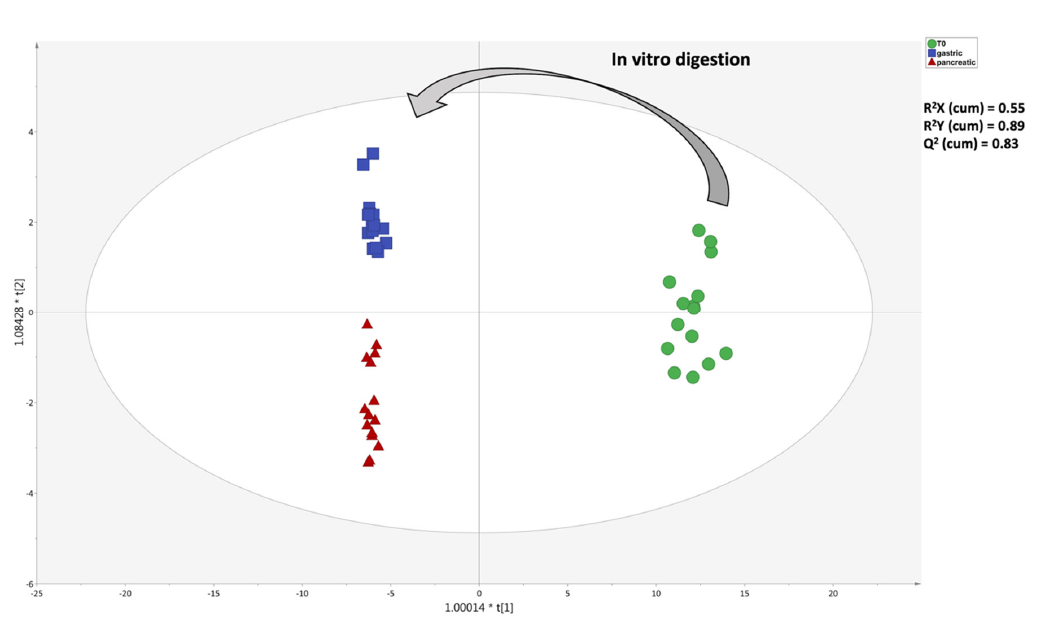
Figure 2. Orthogonal projection to latent structures discriminant analysis (OPLS-DA) score plot showing the modifications of the phytochemical composition of EVOO samples, moving from T 0 (raw; prior to digestion) to gastric and pancreatic phases of in vitro gastrointestinal digestion.